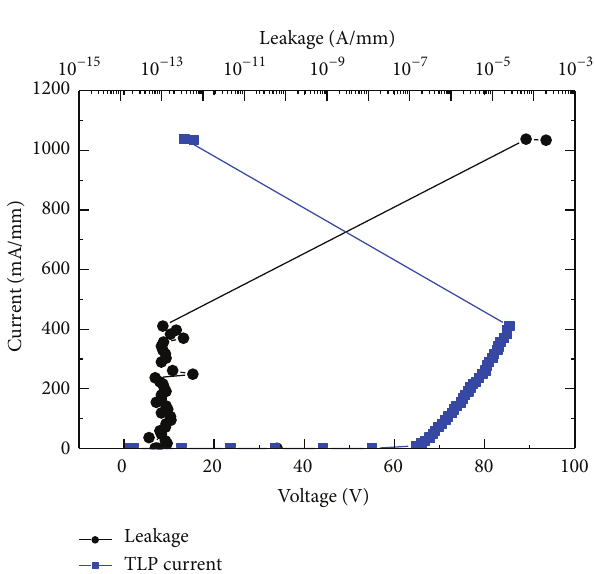
Figure 5: (a) Focus load pull system and (b) its schematic diagram.